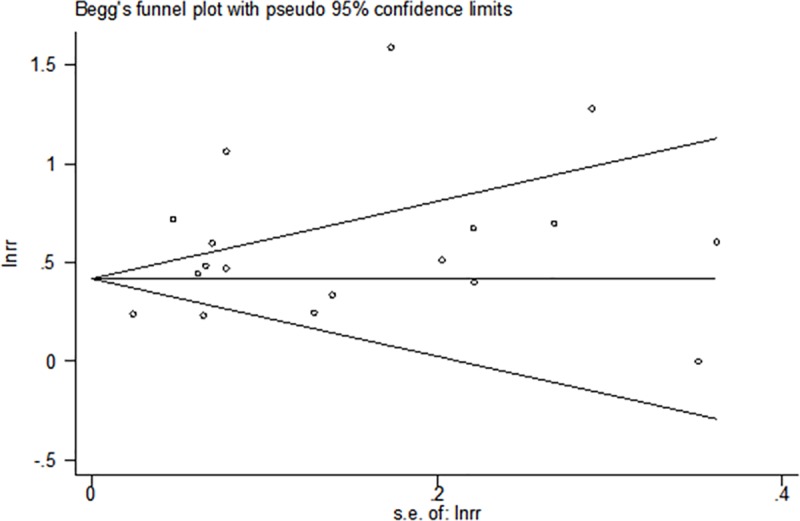
Begg's funnel plot.